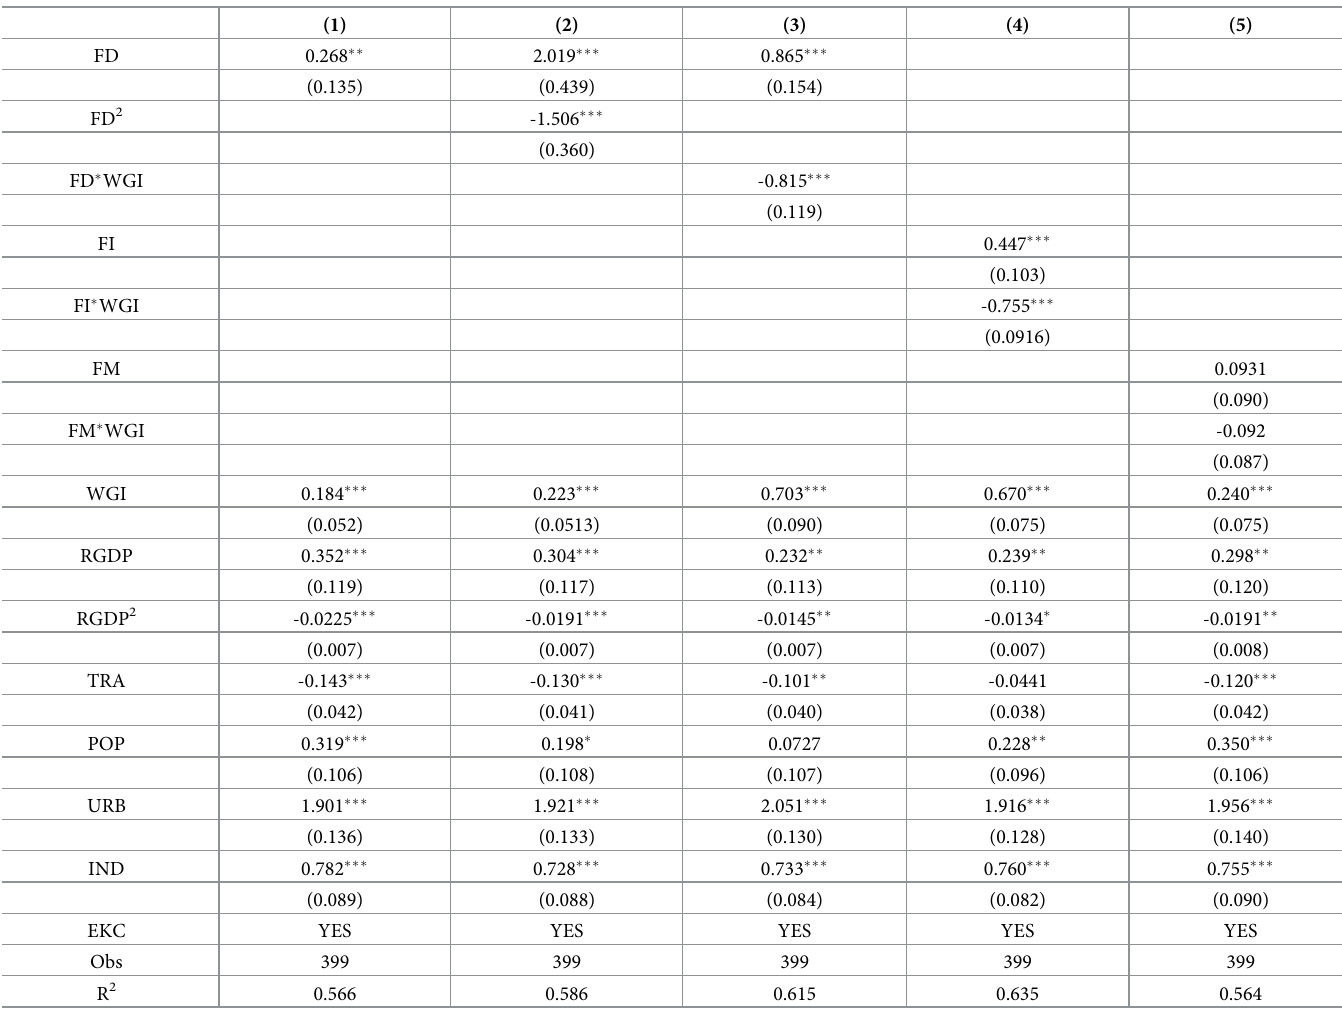
Table 3. Results of benchmark